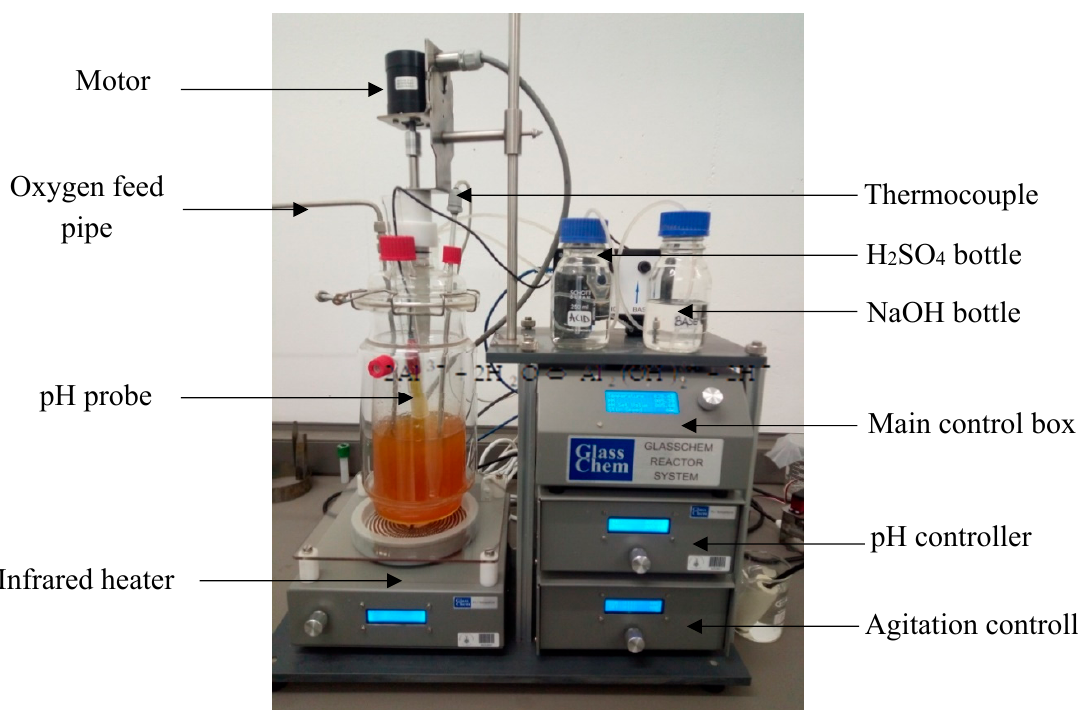
Figure 1. Picture of the experimental setup for the acid mine drainage (AMD) precipitation experiments using NaOH and H 2 SO 4 at 25 °C. Table 1. Factors and values selected for co-precipitation of iron and